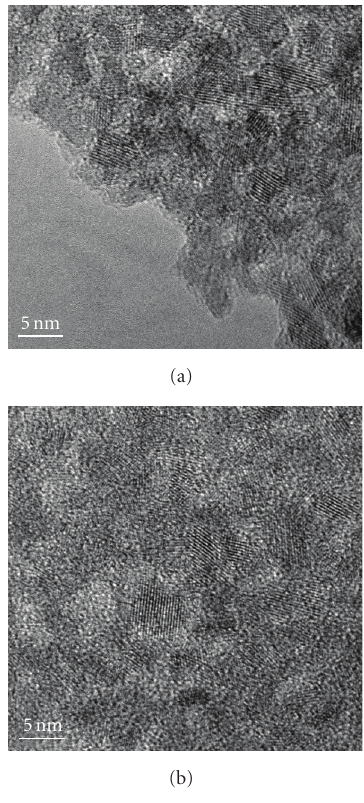
Figure 2: TEM images of samples, TDN (a) and TNB (b).